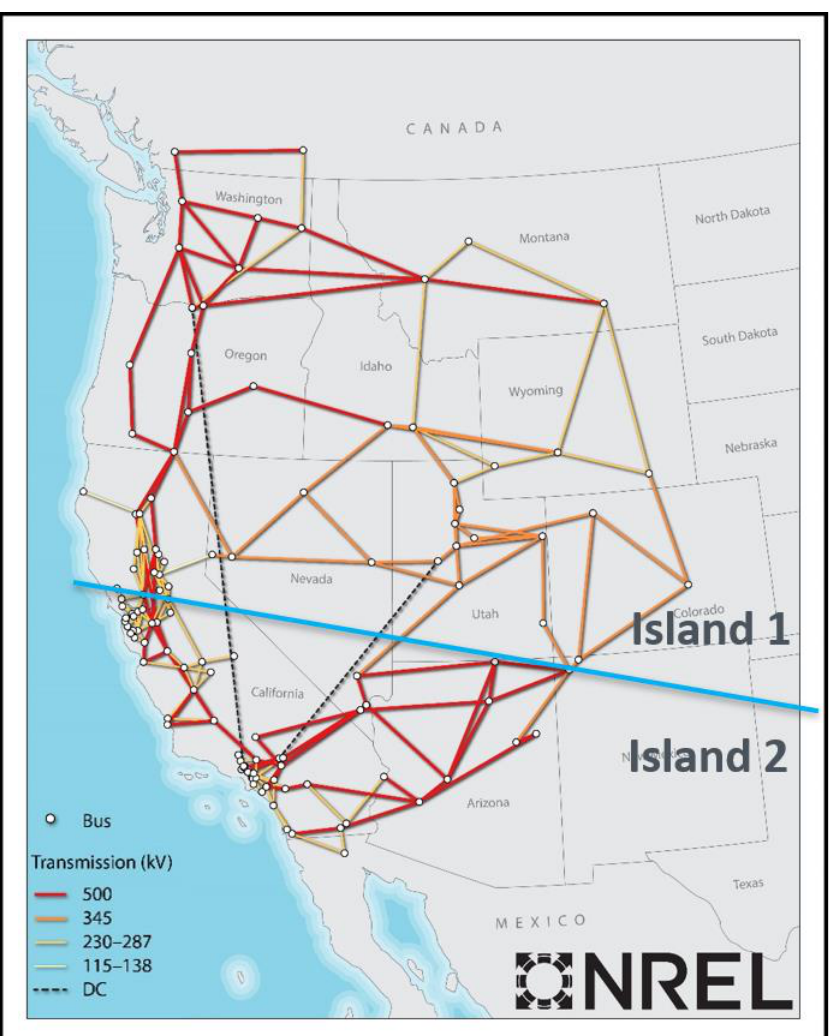
Figure 3. One-line diagram of 240-bus WECC test system model.